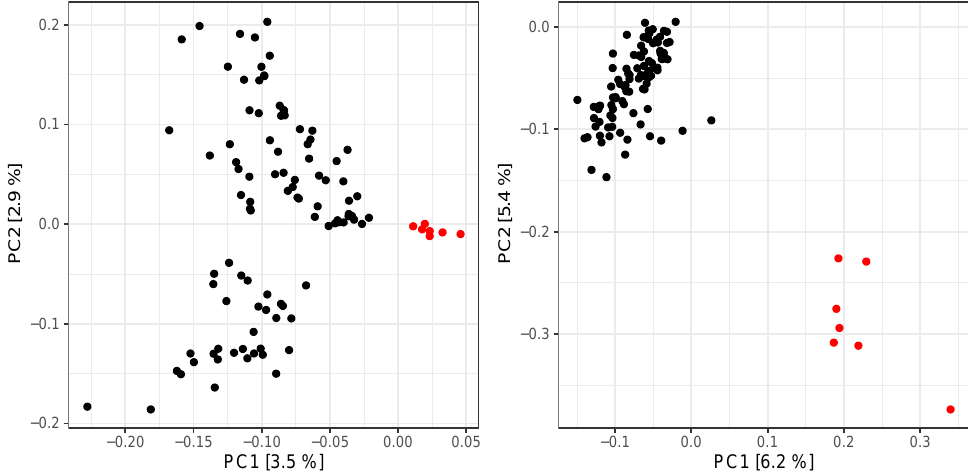
Figure 7. Spectral decomposition of relatedness matrix. Spectral decomposition of G1 [42] ( left plot ) and G5 [59] ( right plot ) relationship matrices, red points represent individuals belonging to other Eucalyptus species or putative